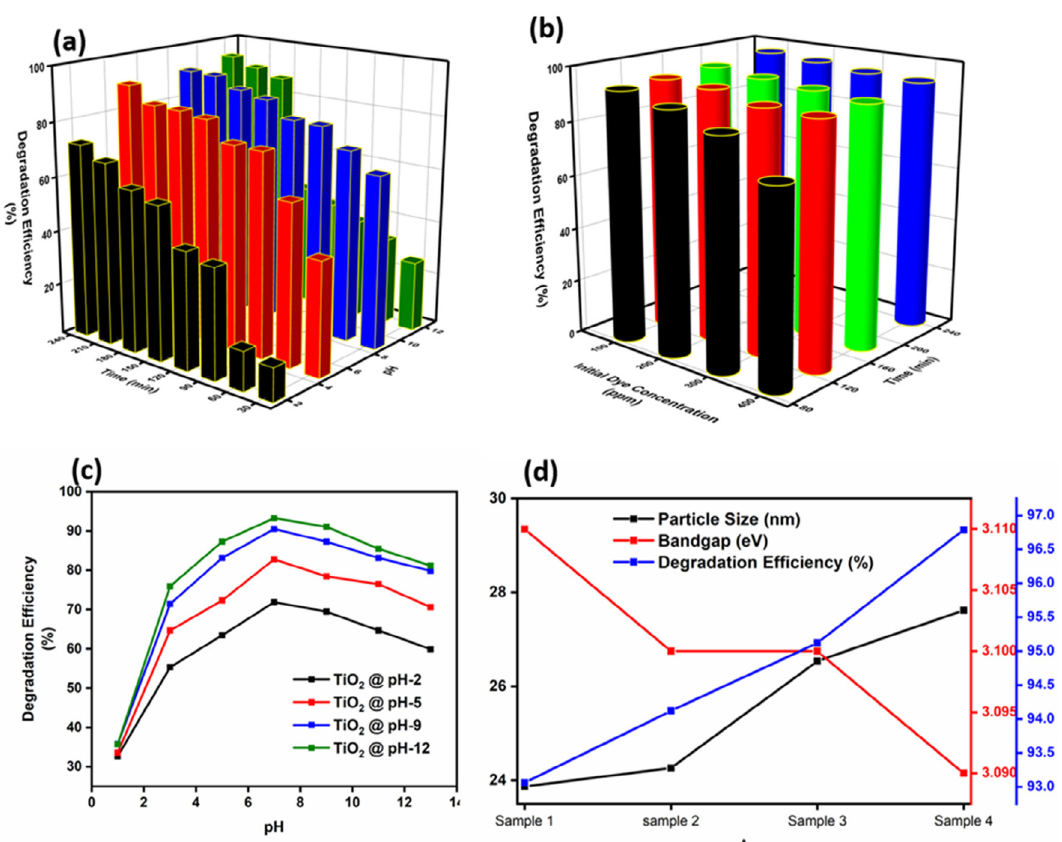
Fig. 9. Dependence of (a)time, (b) initial Concentartion, (c) pH on degrading Malachite Green dye with TiO Comparision graph of Particle size, Bandgap and photocatalytic degradation efficiency.